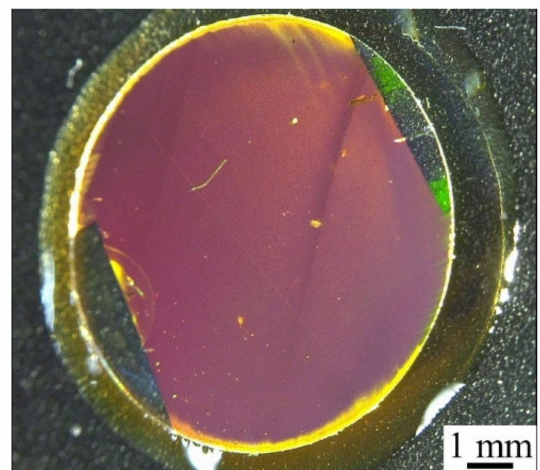
Figure 3. Photograph of PC fabricated using template stripping